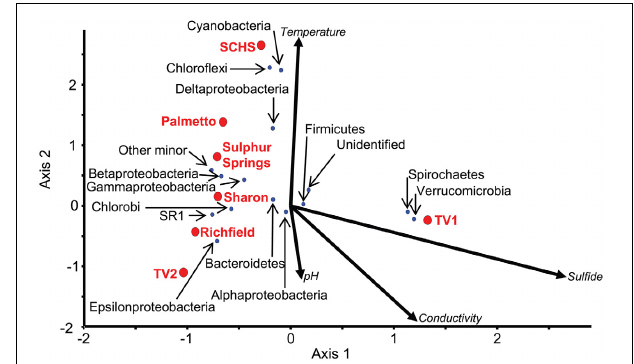
FIGURE 4 | CCA of 16S rRNA pyrosequences summarized by major taxonomic group ( P -value = 0.04). Red dots represent the sampled springs. Blue dots represent OTUs defined by 16S rRNA gene pyrosequences for major taxonomic groups from the springs. Arrows represent environmental